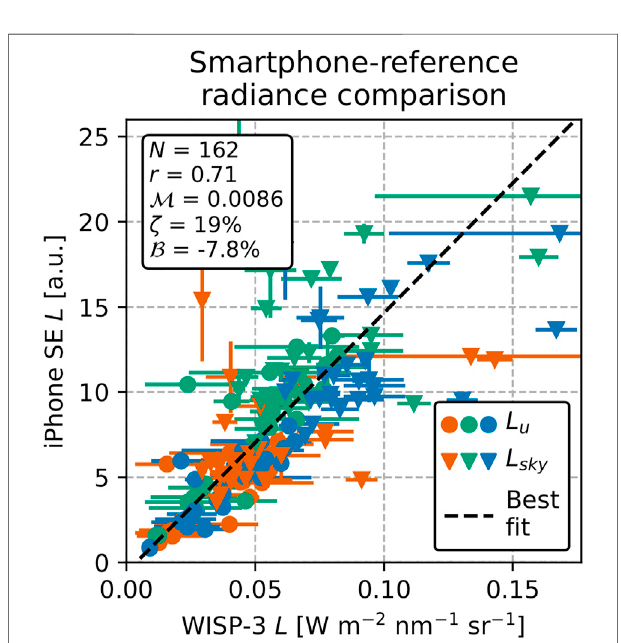
FIGURE 10 | Comparison between iPhone SE and spectrally convolved WISP-3 radiance measurements. The RGB channels are shown in their respective colors, with different symbols for L u and L sky . The statistics in the text box are relative to the regression line. We note that this regression line cannot be used as a general absolute radiometric calibration for the iPhone SE due to the arbitrary choice of exposure settings. FIGURE 11 | Comparison between iPhone SE and spectrally convolved